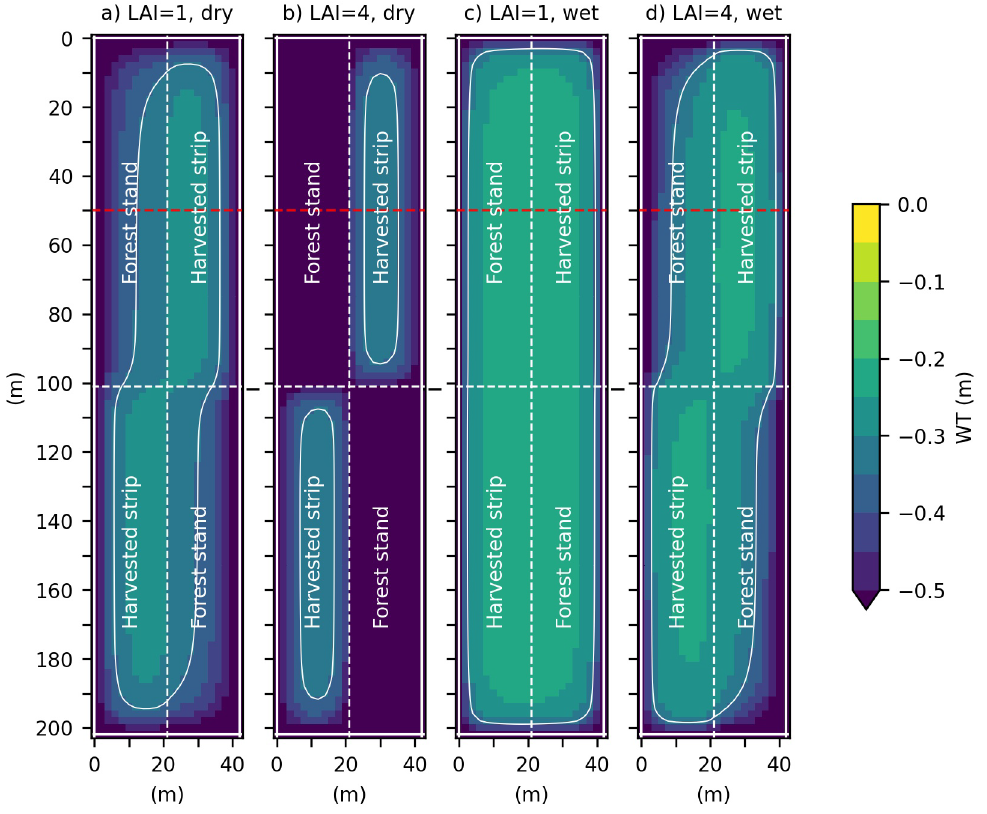
Figure 5. Snapshots of simulated WTs in a single day at the end of August in dry ( a , b ) and wet growing seasons ( c , d ). White contour lines ( a – d ) represent the isolines for a WT = −0.35 m. Unharvested stands and harvested (treeless) strips are separated by dashed, white lines. The peat profile was set to Sphagnum , and the ditch depth at the outer boundaries was equal to − 0.6 m. Red, dashed lines indicate the location of the cross-sections presented in Figure